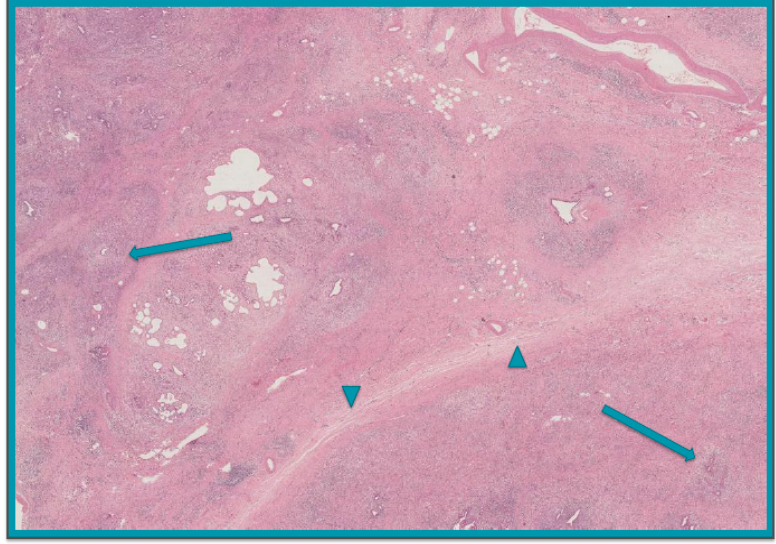
Figure 2. Histological features of autoimmune pancreatitis showing a dense periductal infiltration of plasma cells and lymphocytes leading to obliteration of the affected veins ( arrows ), and peculiar storiform fibrosis ( head arrows ) (hematoxylin ‐ eosin, original magnification × 100).